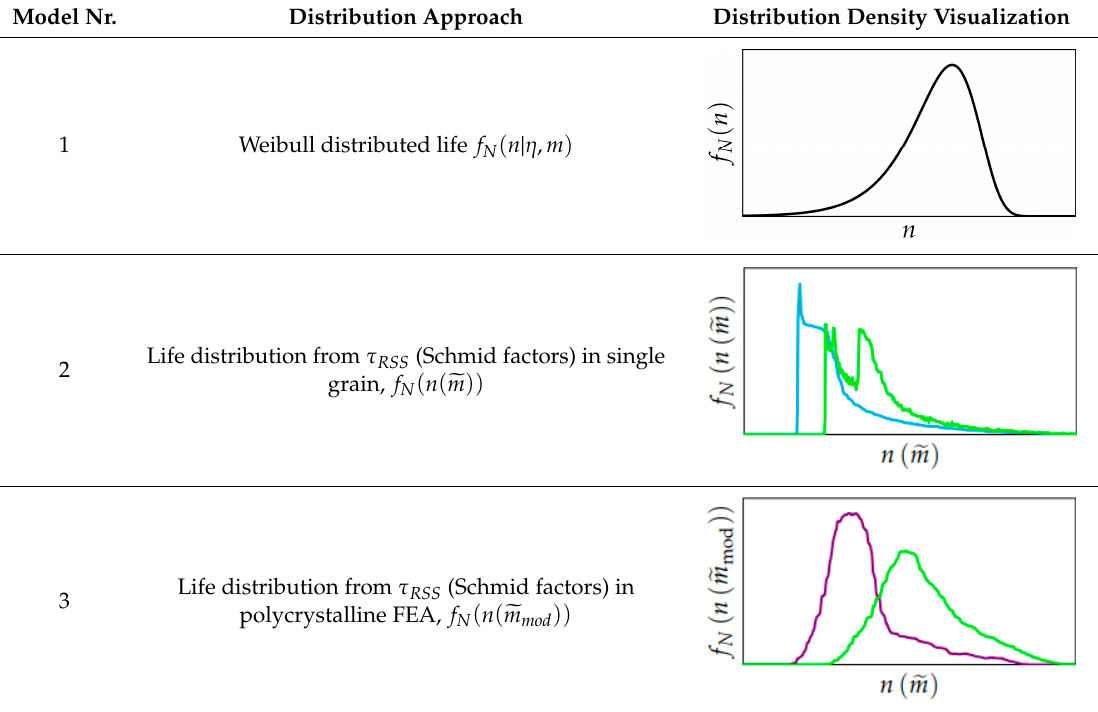
Table 5. Comparison of crack initiation life distribution densities for the applied probabilistic crack initiation model approaches. Model Nr.